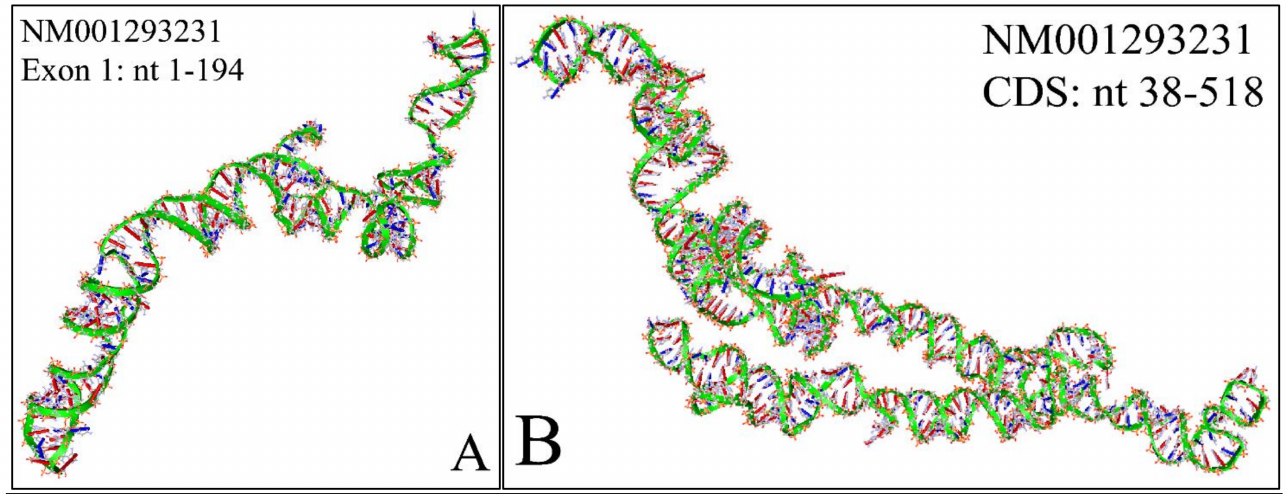
Figure 11. The predicted 3D structure of the MYCN , NM001293231 transcript and in particular, of the first exon (Nucleotides 1–194) ( A ) and the CDS (Coding DNA Sequence) sequence (nucleotides 38-518) ( B ) (3D structure was predicted using the RNAcomposer web-tool [87,88] and it was then visualized using the Accelrys Discovery